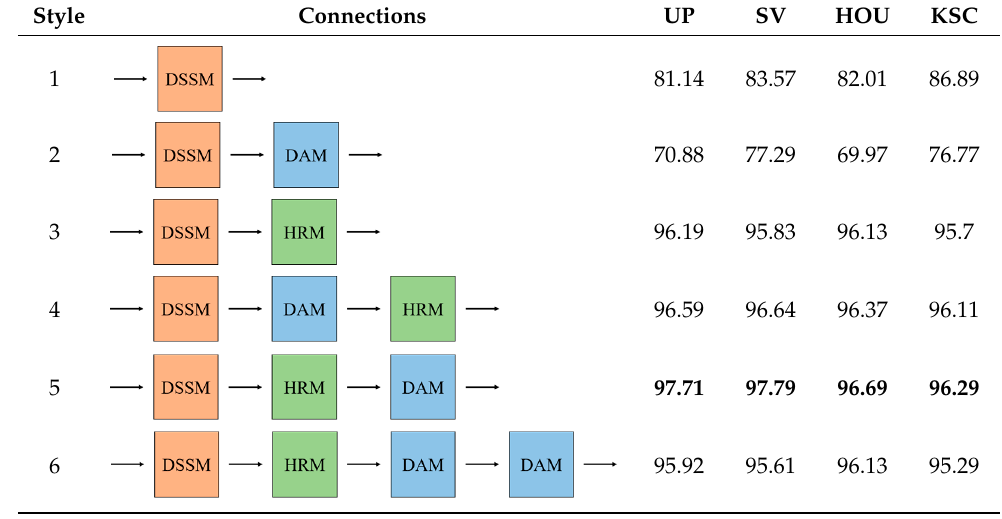
Figure 14. OA with different values of 𝑘 and patch sizes. ( a ) UP. ( b ) SV. ( c ) HOU. ( d ) KSC.